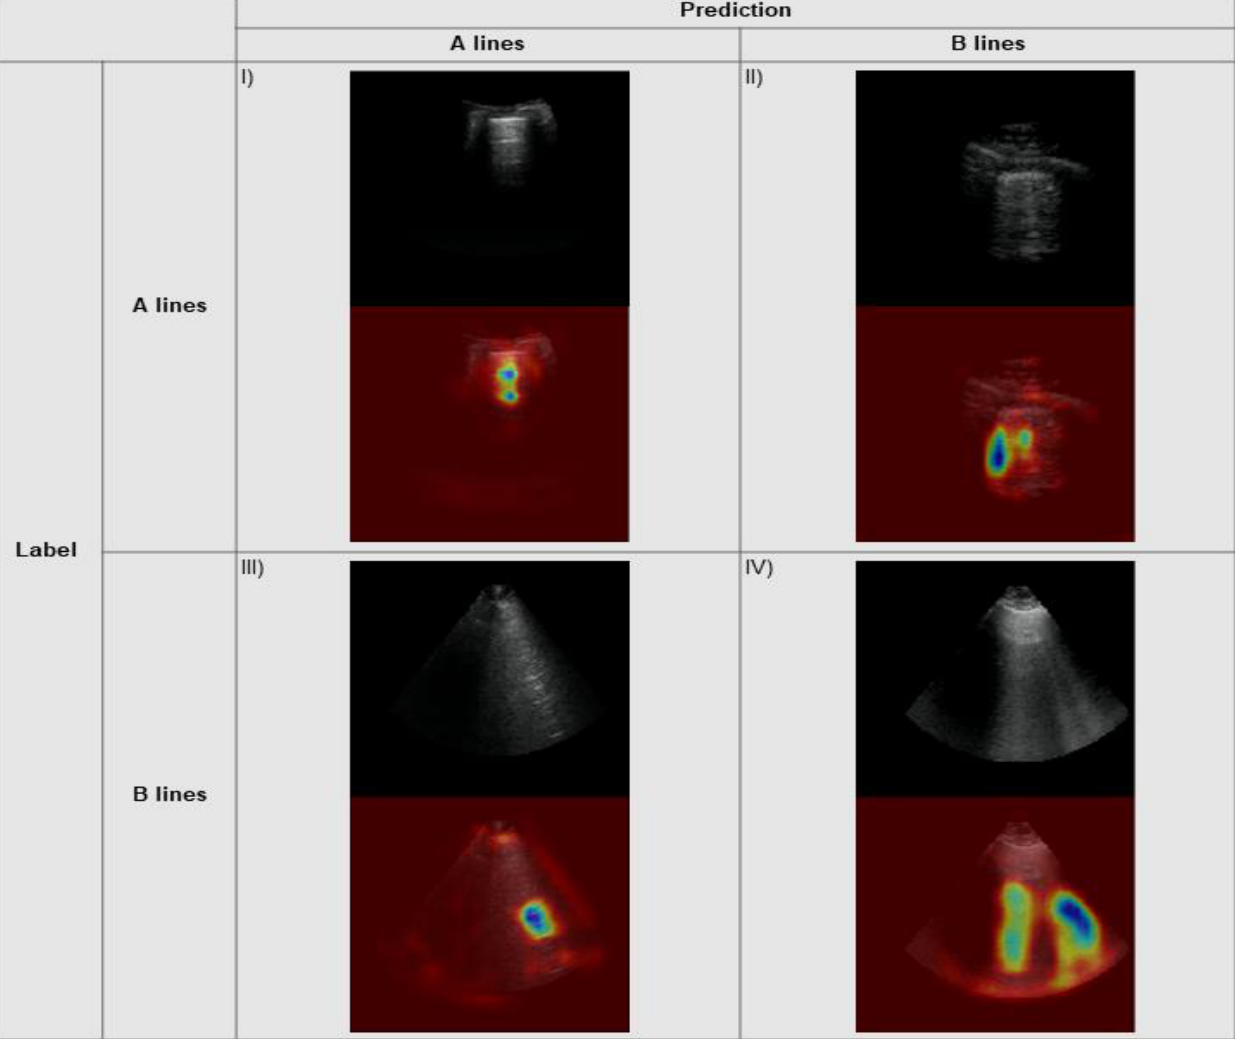
Figure 7. Grad-CAM heatmaps overlying example frames from our local data: ( I ) Correctly predicted A line frame with a prediction probability of 0.96; ( II ) A line frame incorrectly predicted as a B line frame with a prediction probability of 0.69 for B line; ( III ) B line frame incorrectly predicted as an A line frame with a prediction probability of 0.86 for A line; ( IV ) Correctly predicted B line frame with a prediction probability of 1.00.